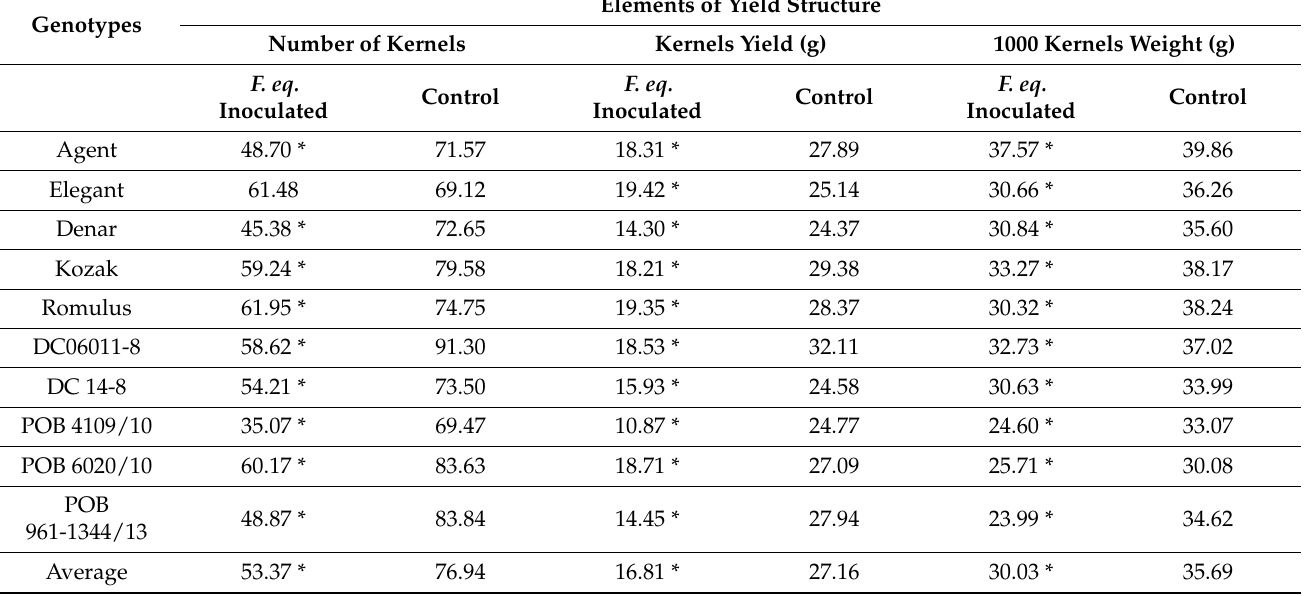
Table 1. Effect of oat panicle inoculation with F. equiseti No O-020 on the number of kernels